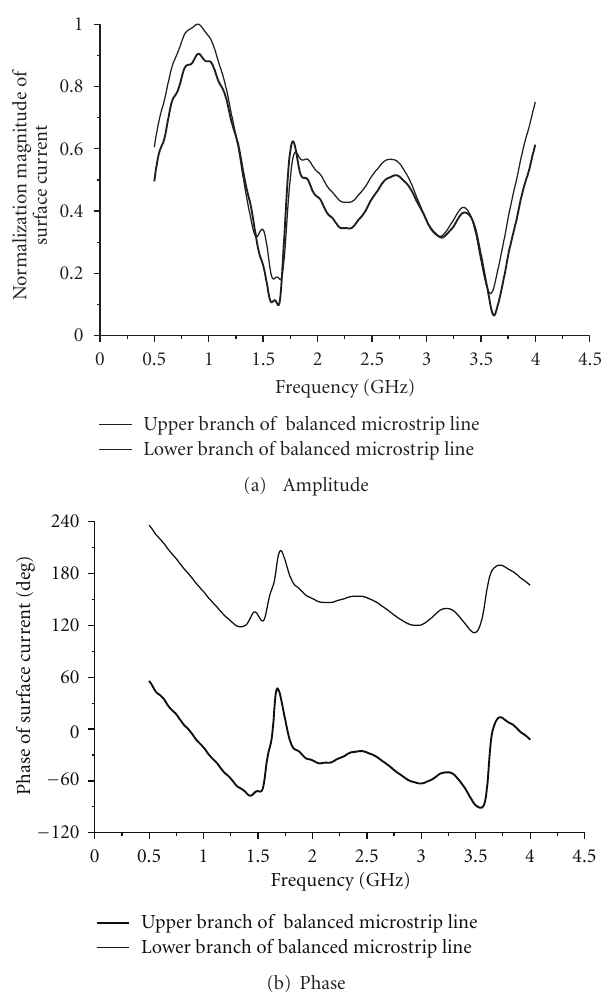
Figure 6: Simulated results of surface current on the terminal of the balanced microstrip line.